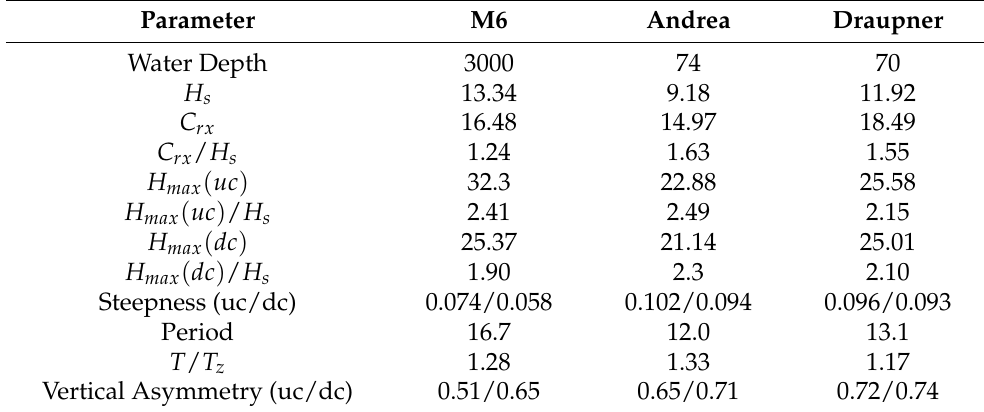
Table 4. Comparison between M6 rogue wave and other notable rogues. Note that the depth at which the M6 rogue occurred is substantially different. Where relevant, parameters are calculated using both up-crossing (uc) and down-crossing (dc)